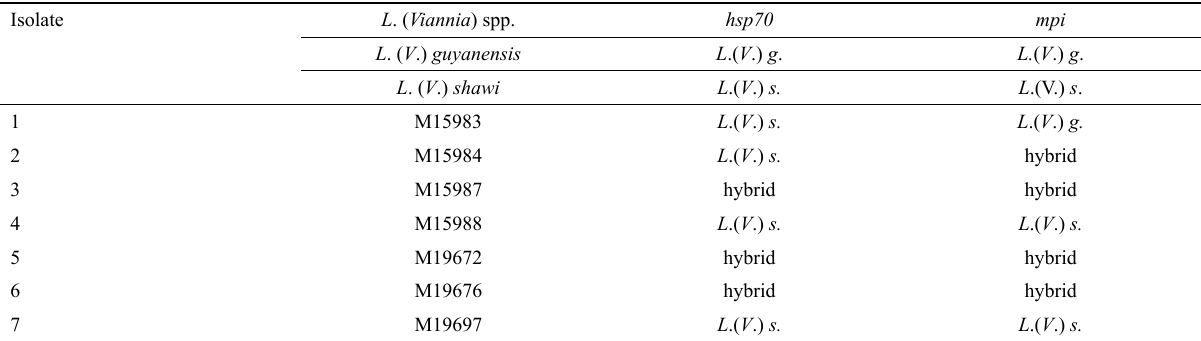
Table 2 – Isolates profile according to hsp70 and mpi PCR-RFLP.